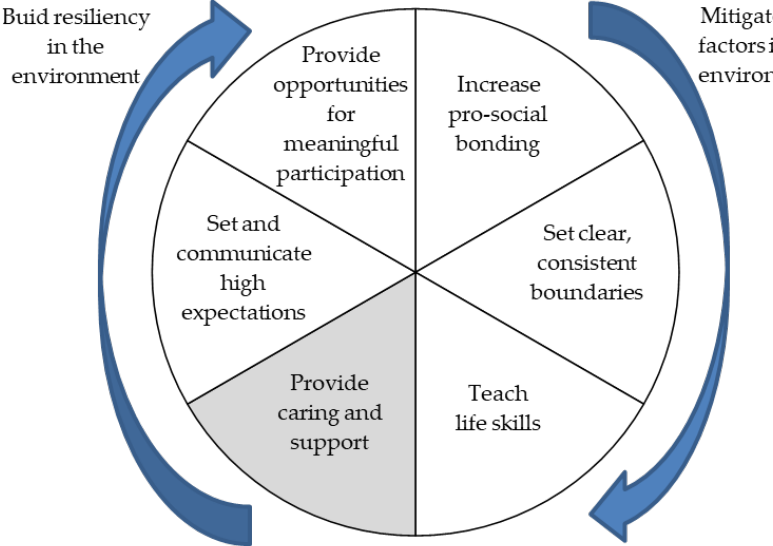
Figure 2 The Resiliency Wheel. Adapted from [20]. Figure 2. The Resiliency Wheel. Adapted from